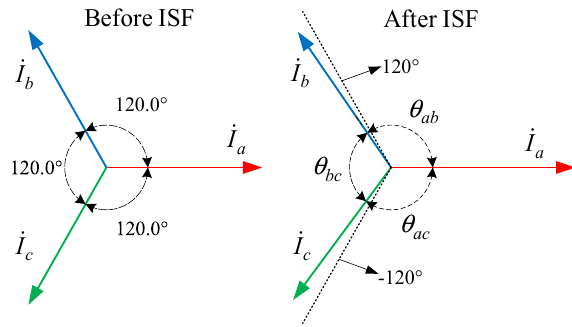
Figure 4. Phase angle changes with ISF in phase a .